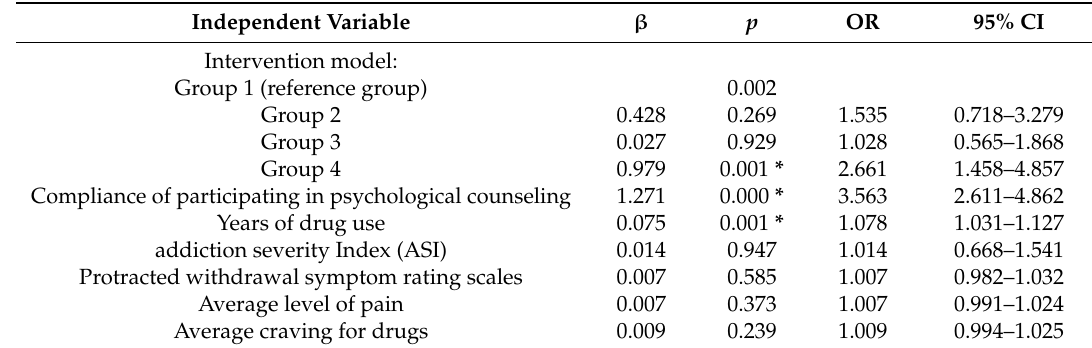
Table 5. The result of the multivariate Cox regression